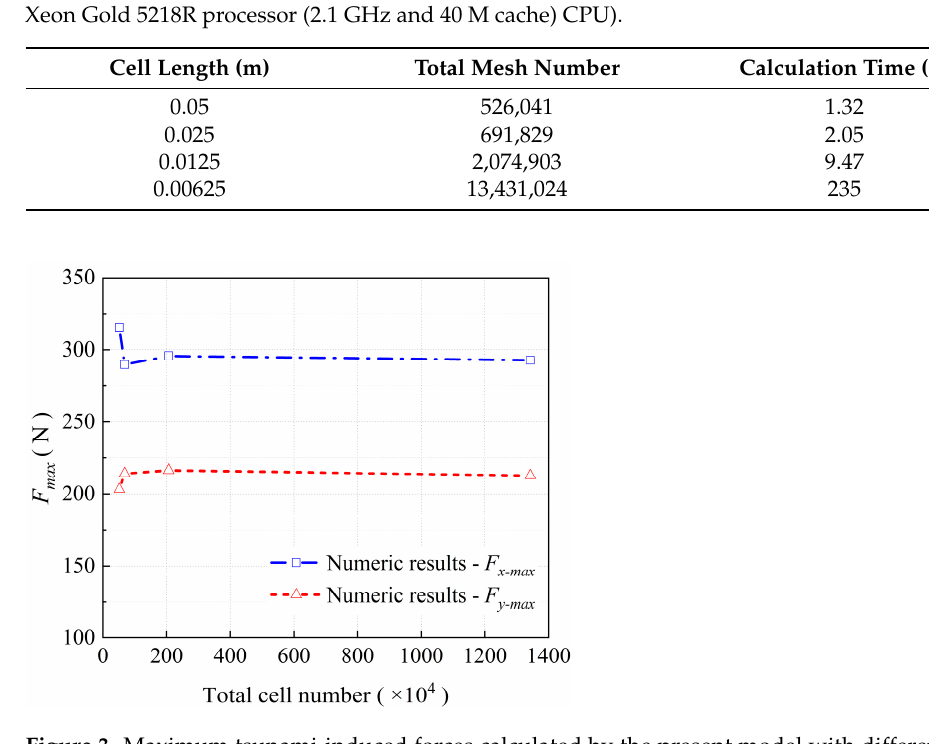
Table 2. Mesh sensitivity testing of the main calculation zone (using a computer with a double Inter Xeon Gold 5218R processor (2.1 GHz and 40 M cache) CPU).